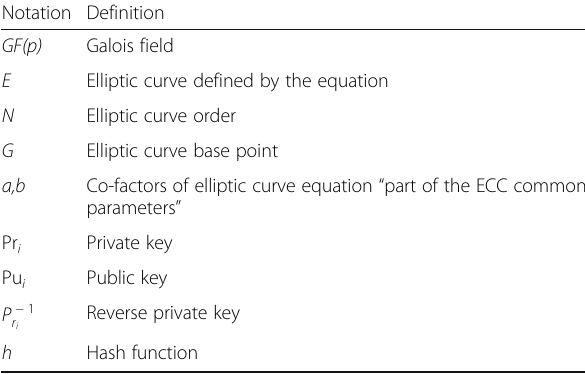
Table 1 Definition of notations used in the proposed